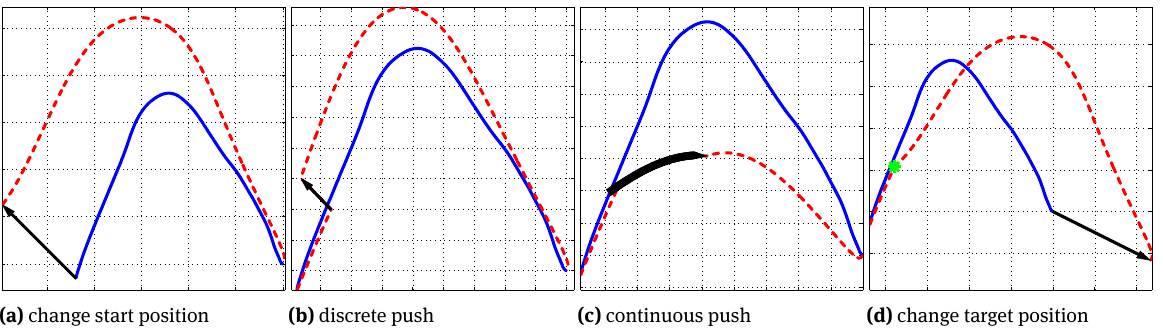
Figure 3: Four different benchmark scenarios used in the benchmark software framework to test generalization capabilities. The blue trajec- tory (solid line) is the demonstrated motion, whereas the red trajectory (dashed line) is the perturbed motion generated in the simulation. The black arrow indicate the direction and amplitude of the applied